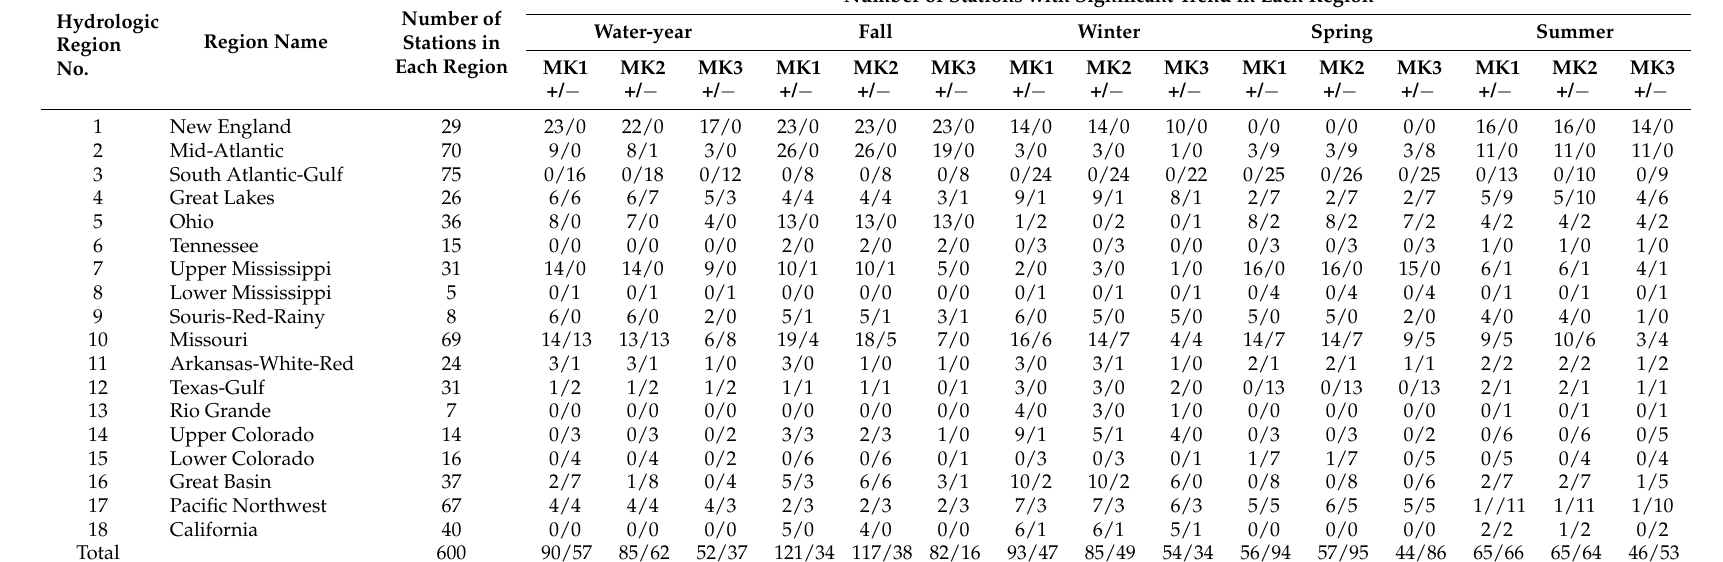
Table 1. Results of the three Mann-Kendall (MK) tests at each hydrologic region for water year and the four